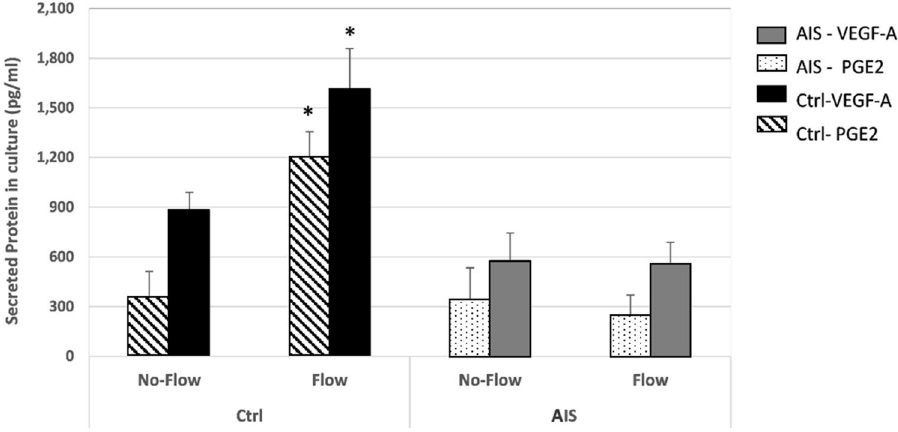
Figure 5. Fluid flow does not induce neither VEGF-A nor PGE2 secretion in AIS osteoblast cells. The quantity of secreted VEGF-A and PGE2 were measured in the media of both AIS and Control cultured cells, following 20 h fluid flow application in comparison to their stationary counterparts. N = 4 per group, each standard error bar is constructed using 1 standard error from the mean in JMP-14 software. * Student T-test p value < 0.05. Legend; Solid bars: VEGF-A, Patterned bars: PGE2, Darker bars: Controls, Lighter bars: